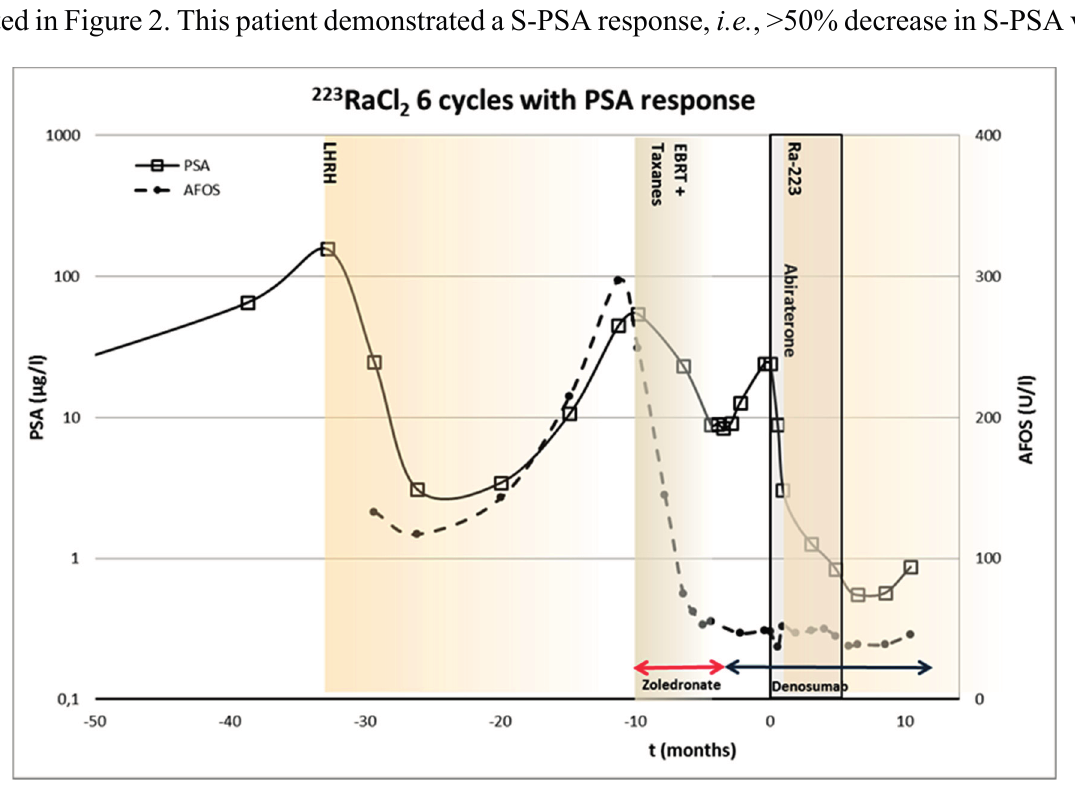
Figure 2. The timing of various treatments of 64-year-old male with prostate cancer (Gleason score 8 (4 + 4)), and 223 RaCl 2 therapeutic dosing schedule. S-PSA and S-AFOS concentrations are presented as well. This patient demonstrated a S-PSA response due to 223 RaCl 2